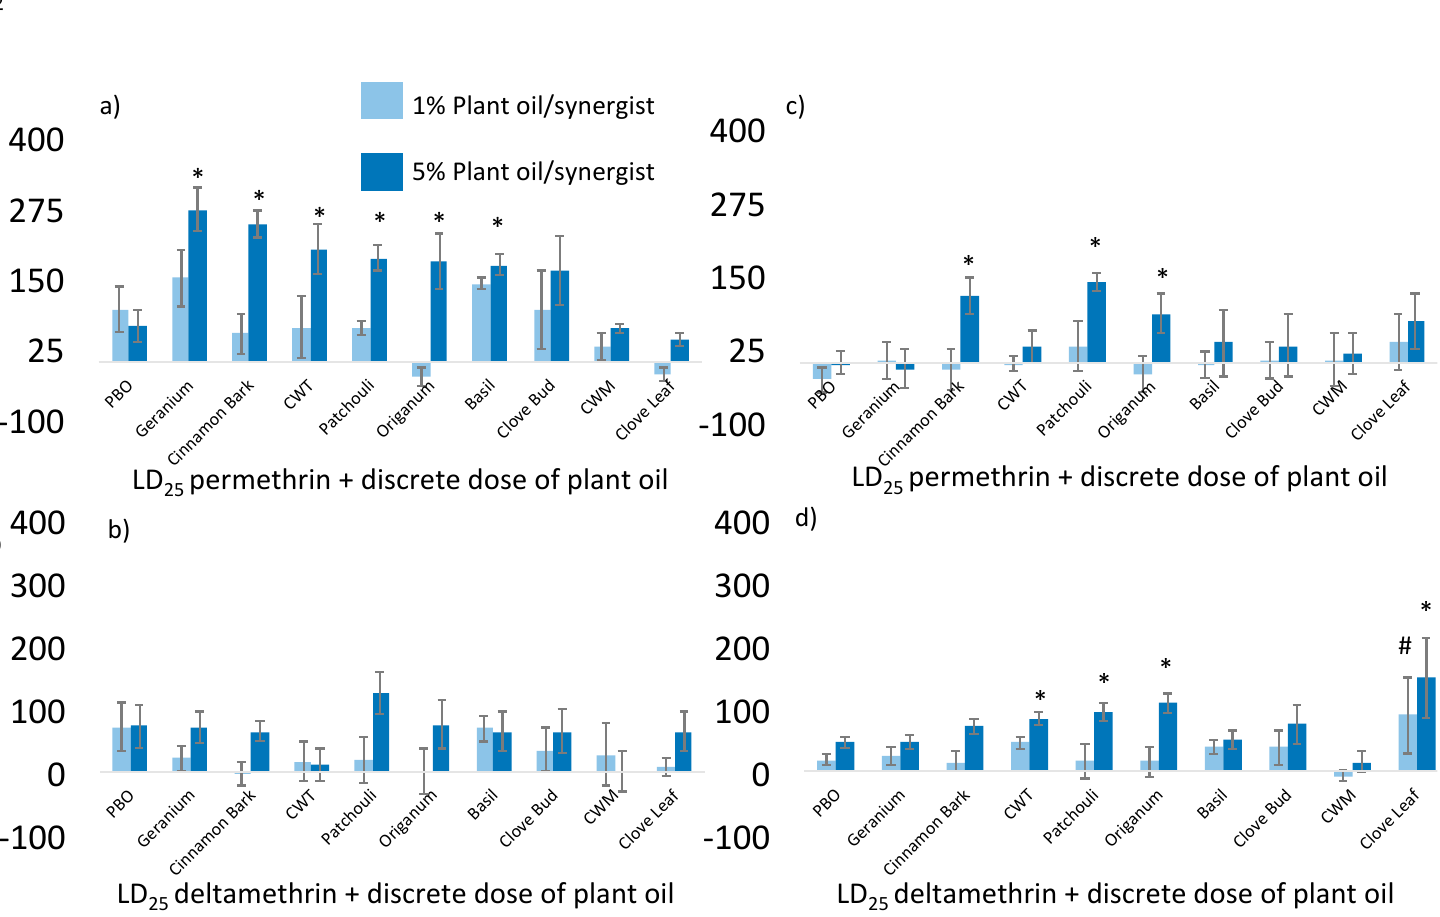
Figure 3. Percentage enhancement caused by plant essential oils applied in combination with select pyrethroids against two Aedes aegypti strains. Percentage enhancement of ( a ) permethrin + plant essential oils against the Liverpool strain; ( b ) deltamethrin + plant essential oils against the Liverpool strain; ( c ) permethrin + plant essential oils against the Puerto Rico strain; and ( d ) deltamethrin + plant essential oils against the Puerto Rico strain. Asterisks denote significantly higher percentage enhancement caused by oils applied at the 5% level than PBO applied at the same concentration. Octothorpes (#) denote significantly higher percentage enhancement caused by plant oils applied at the 1% level than PBO applied at the same concentration.